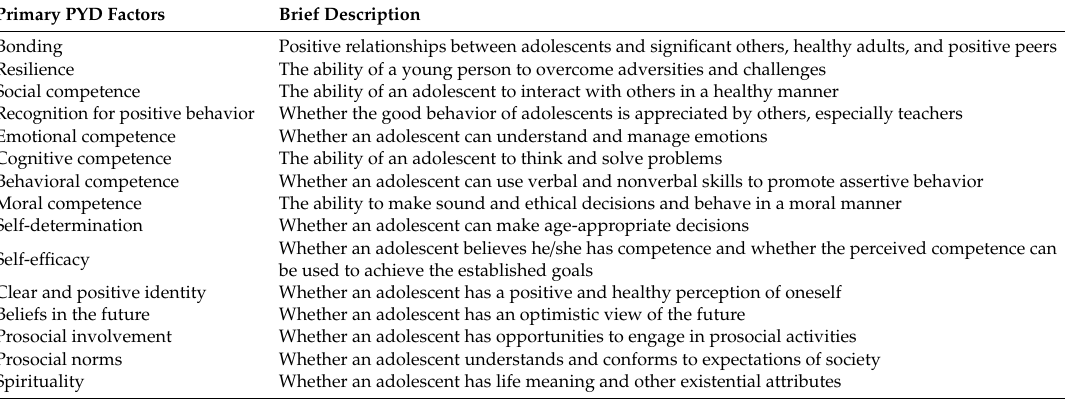
Table A1. Description of 15 PYD attributes summarized by Catalano et